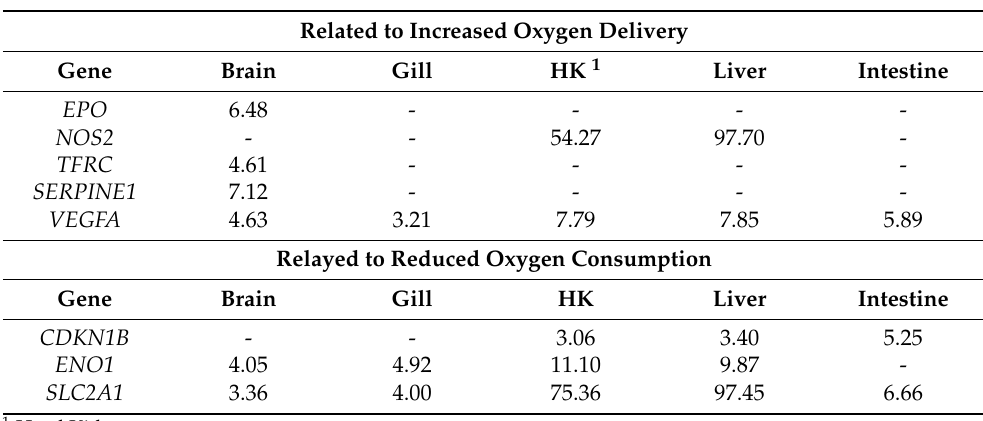
Table 4. Fold changes of oxygen-related genes expressed in the HIF-1 signaling pathway.